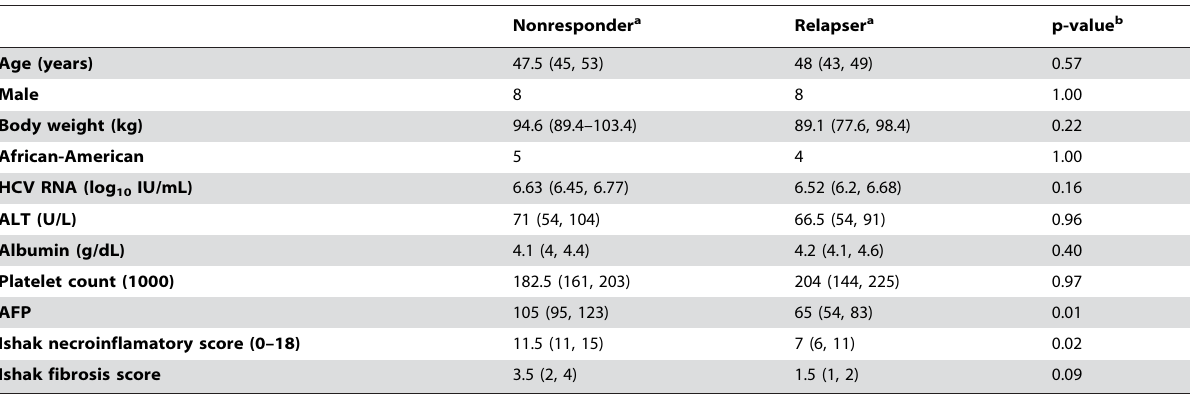
Table 1. Patient characteristics.